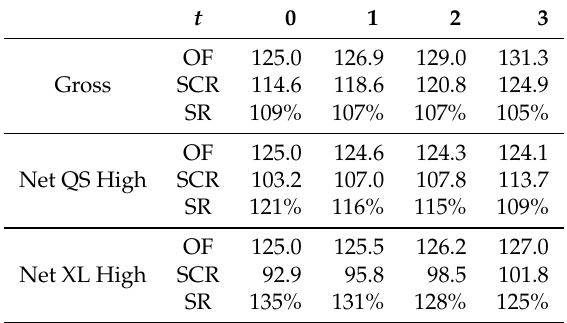
Table 12. SR for Tau during the following 3 years (amounts in mln of Euro) (Liabilities Ptf—40%